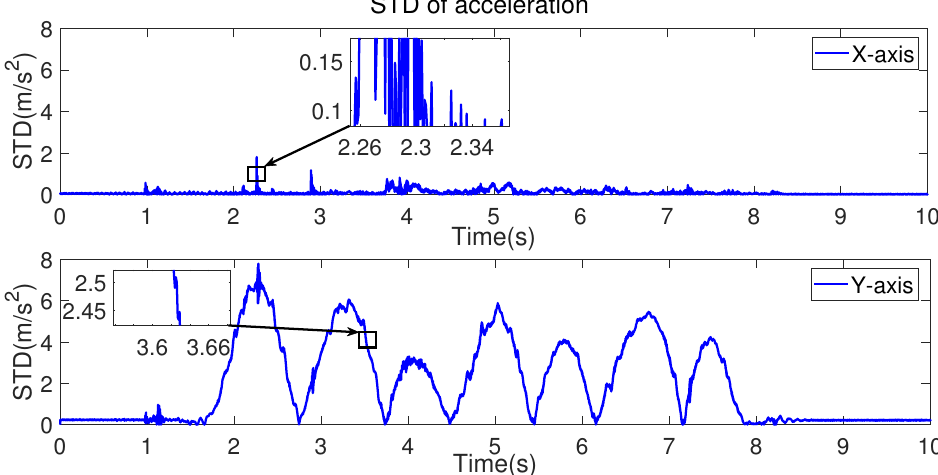
Figure 11. STD of X and Y axes acceleration corresponding to roll